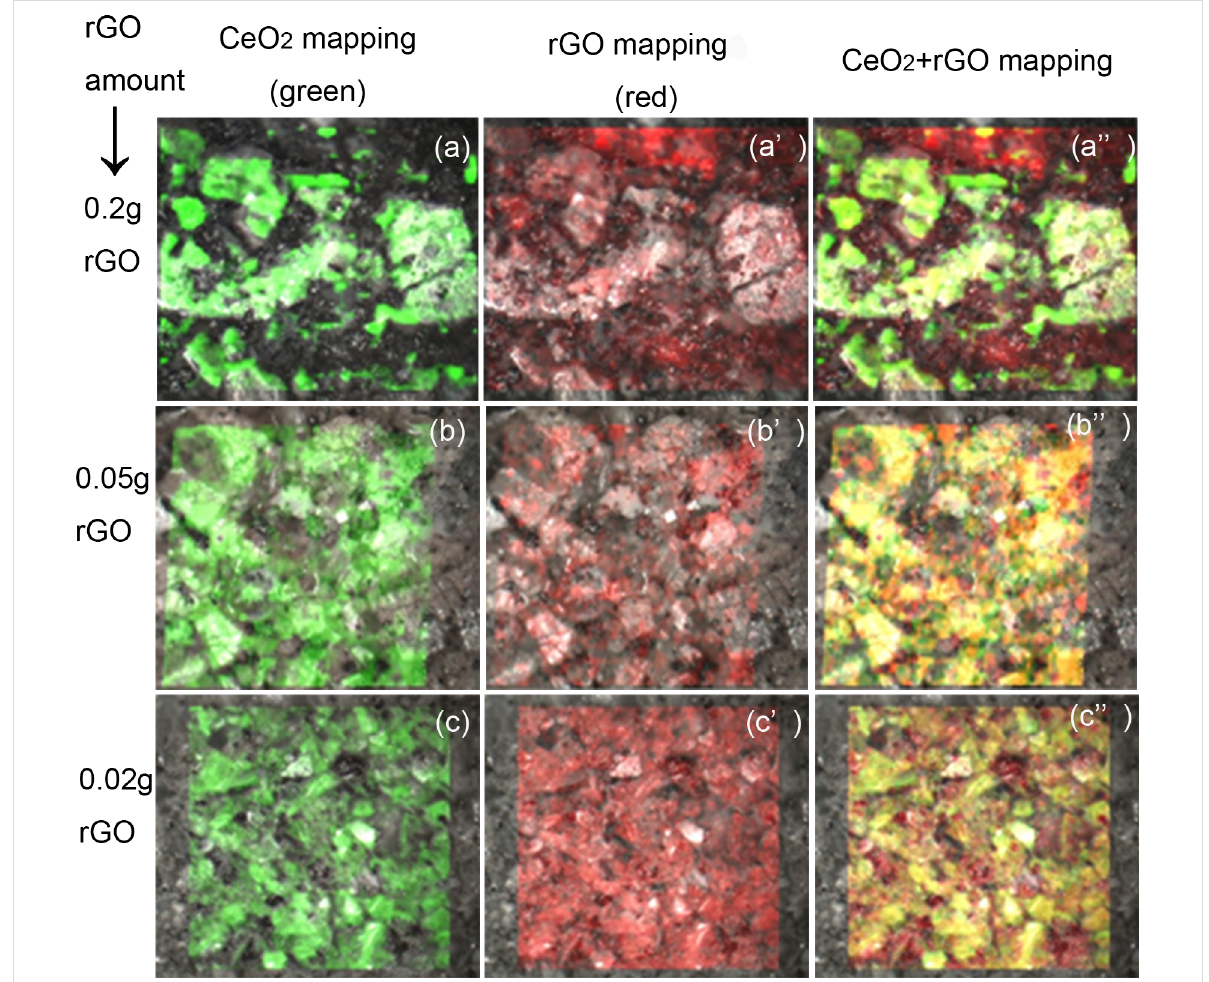
Figure 2: Raman mapping of rGO–CeO 2 composites with different proportions of rGO after solvothermal treatment in ethanol (mapping area: 500 × 500 μ m 2 ).